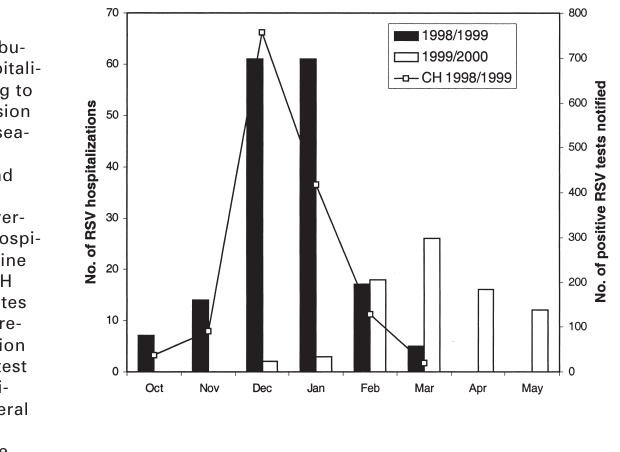
Figure 1 Frequency distribu- tion of RSV hospitali- sations according to month of admission during the RSV sea- sons